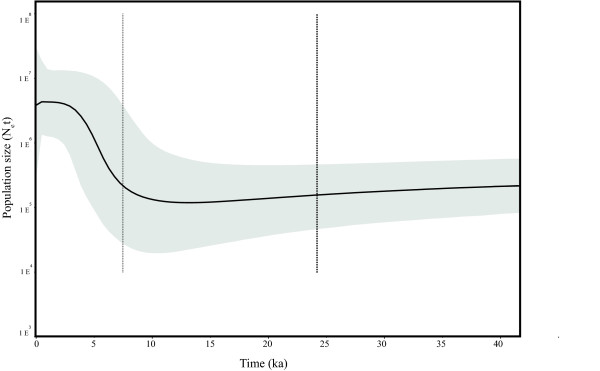
Historical demographic trends of the effective population size (Ne) constructed using a Bayesian skyline plot approach based on Cytochrome oxidase subunit I (COI) haplotypes of N. magellanica. The y-axis is the product of effective population size (Ne) and generation length in a log scale while the x-axis is the time in 103 before present. The median estimate (black solid line) and 95% highest probability density (HPD) limits (grey) are shown. The thick dashed line represents the time of the most recent ancestor (trcma) and the thin dashed line represents time for the expansion in the species.